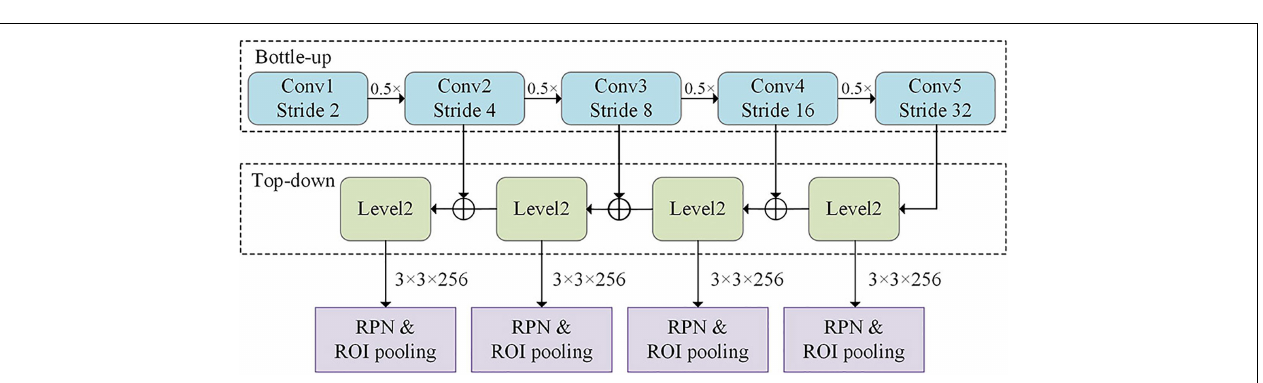
FIGURE 3 | Network architecture of the improved Faster region-convolutional neural network (R-CNN) algorithm, which contains the FPN and region proposal network (RPN).